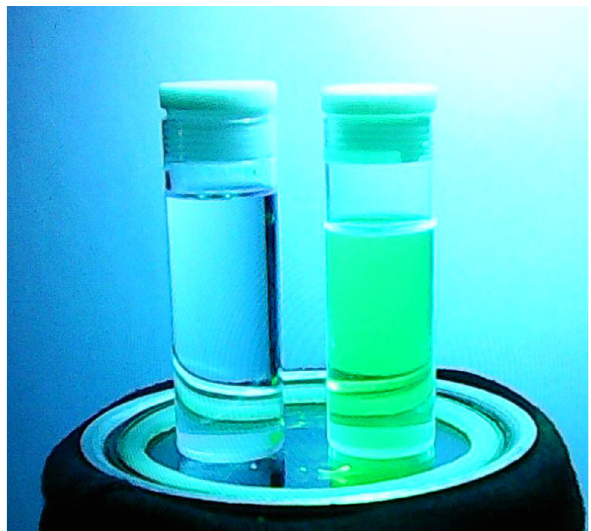
Fig. 1 The sample of the LAB-based scintillator with NOL 37 (vial on the right) and “standard” scintillator with PPO (vial on the left)